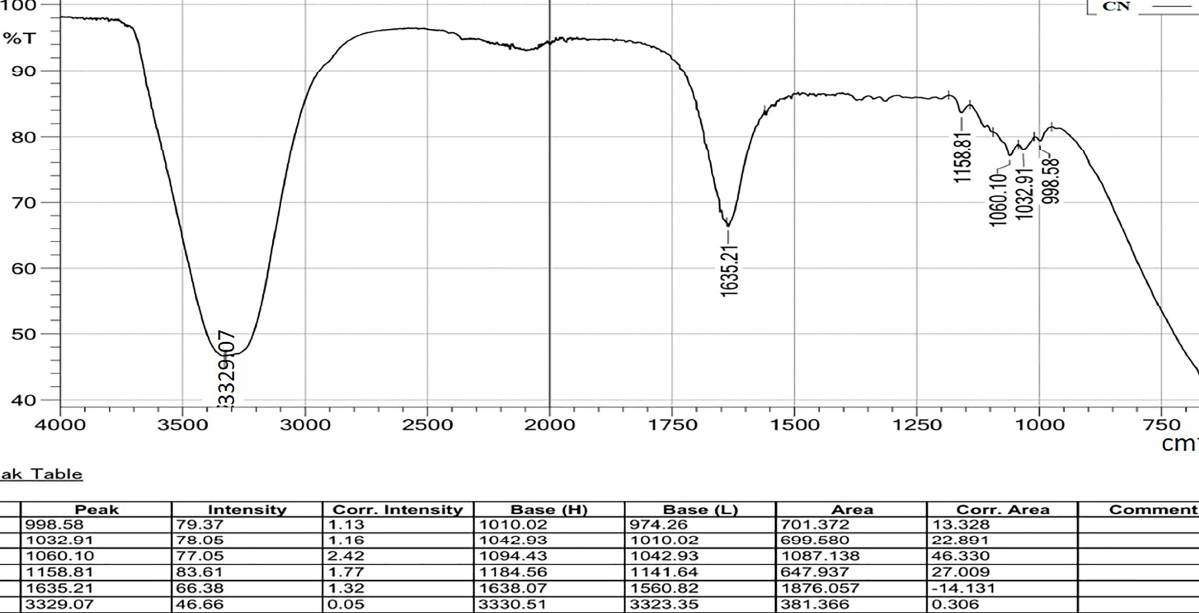
Figure 4. A detailed FTIR spectrum of CN-3, representing the absorption spectra of different groups.